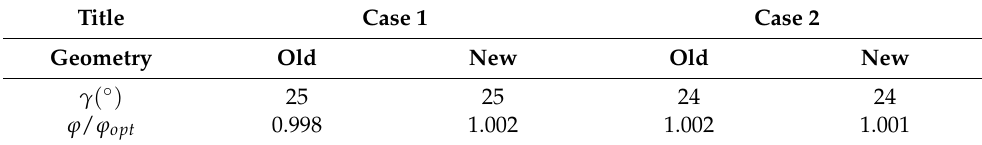
Table 1. Operating points of hydraulic turbines